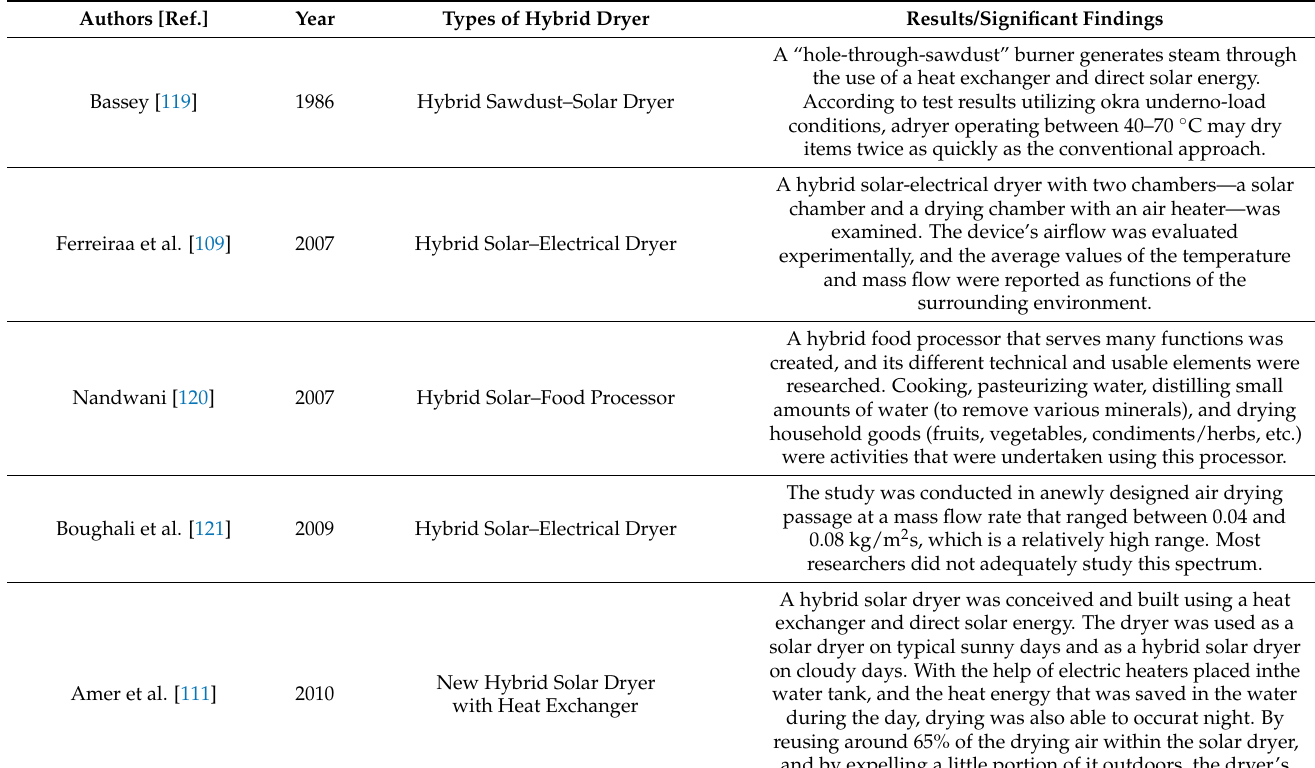
Table 3. Comparison of various types of hybrid greenhouse